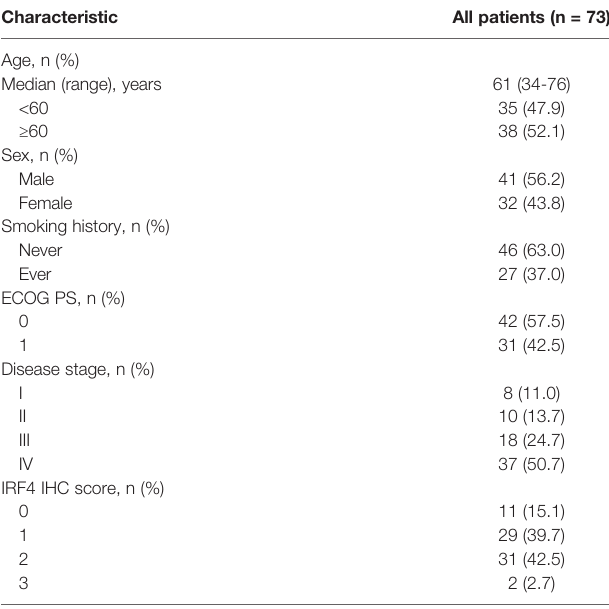
TABLE 3 | Univariate and multivariate analyses of OS in lung adenocarcinoma